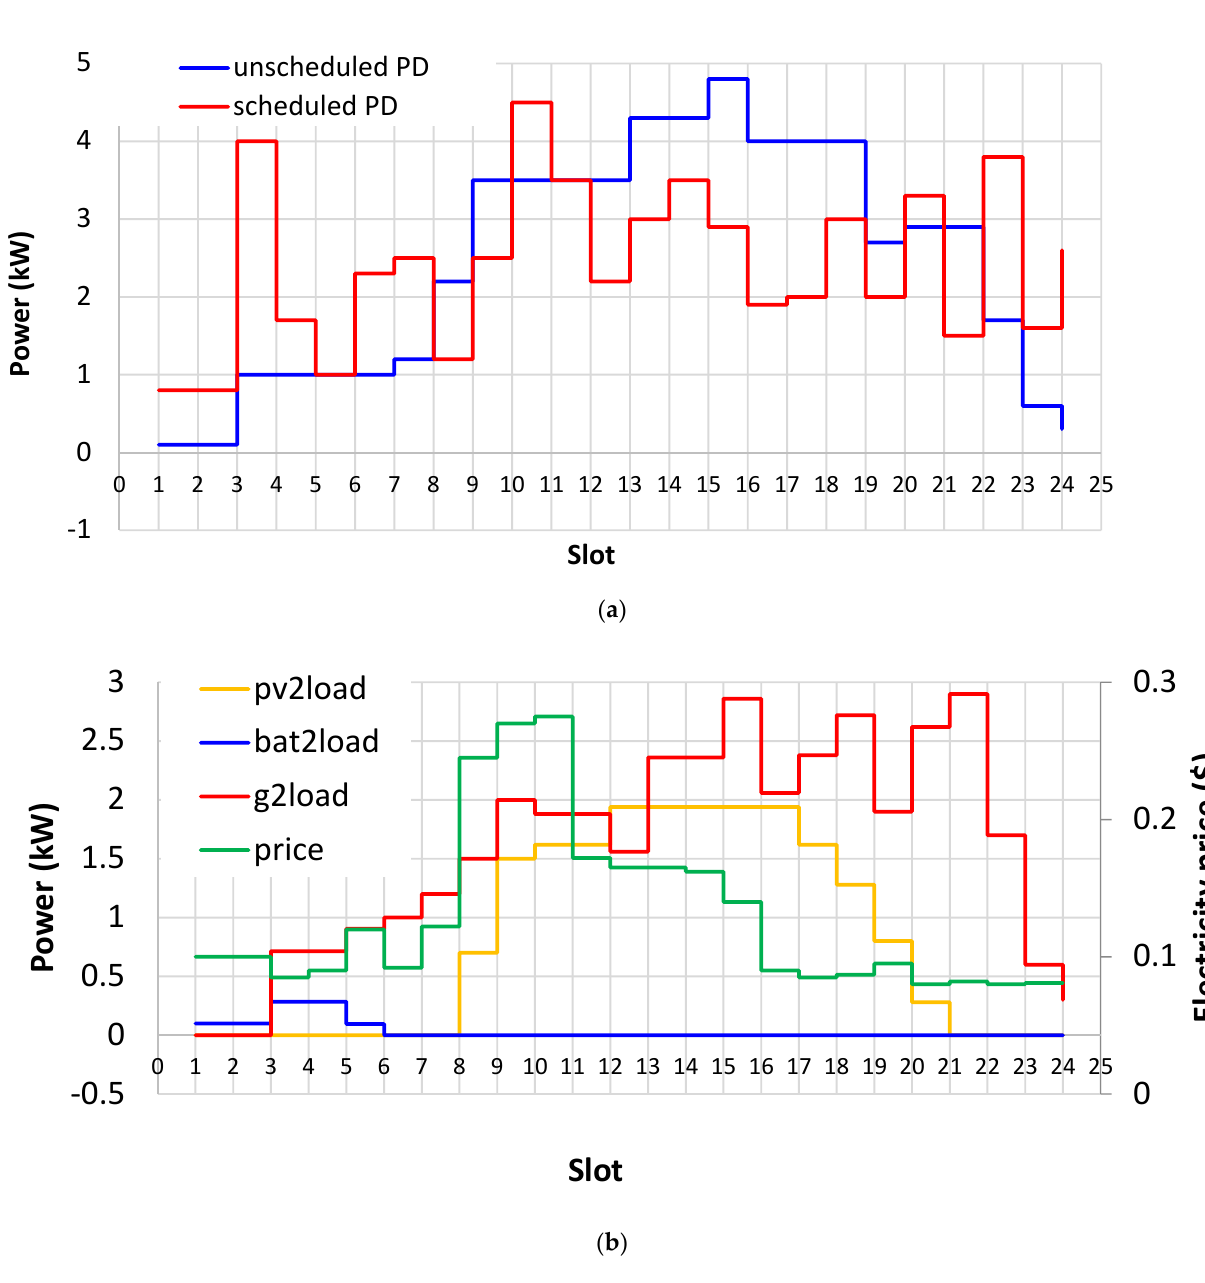
Figure 6. ( a ) The scheduled and unscheduled daily power demand, and ( b ) the powers delivered to the load. pv2load, PV to load; bat2load, battery to load; g2load, grid to load; price, electricity price in $.